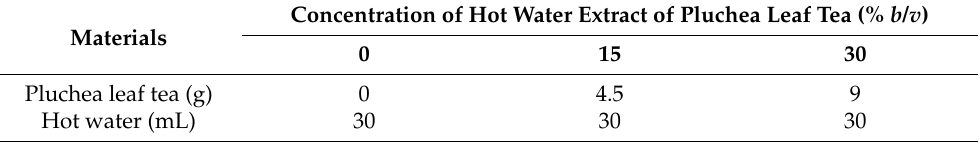
Table 1. The formula of the hot water extract of the pluchea leaf tea.